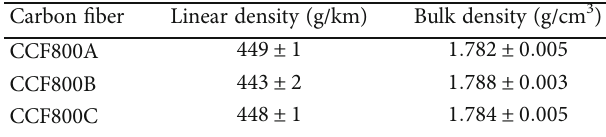
Table 2: The linear and bulk density tests of carbon fi